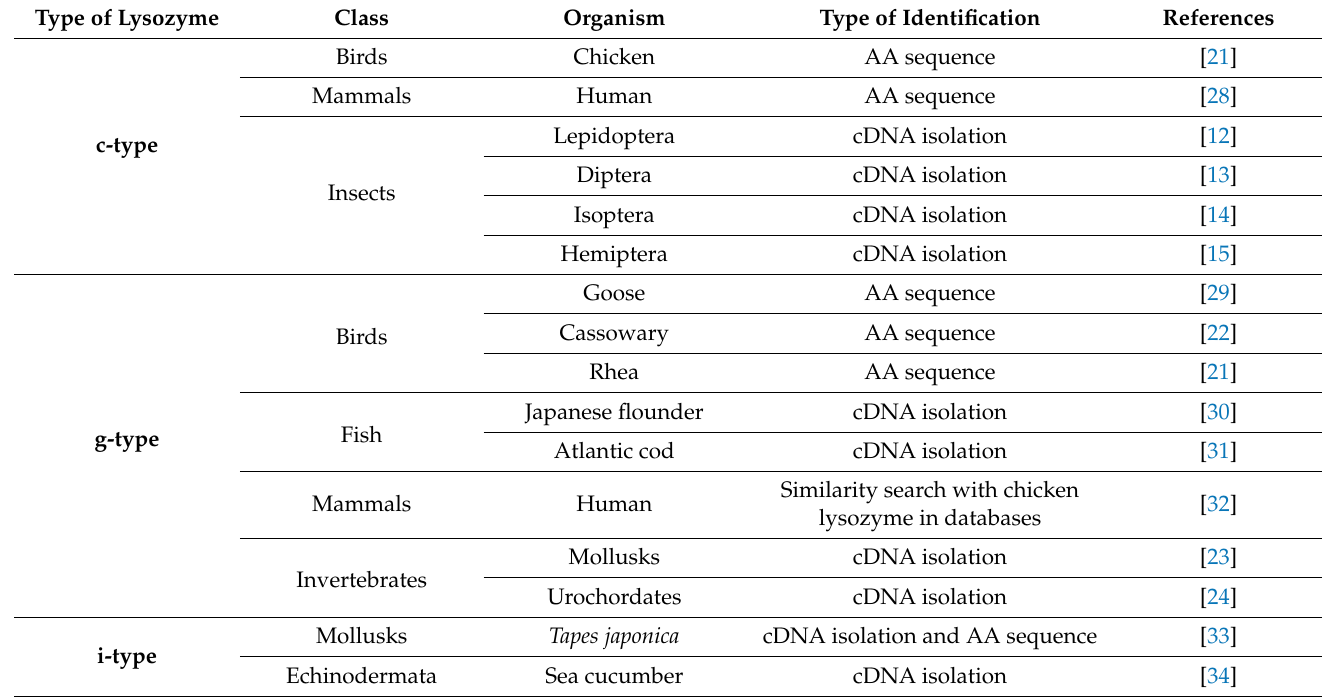
Table 2. Identification of c-type, g-type, and i-type lysozymes in the animal